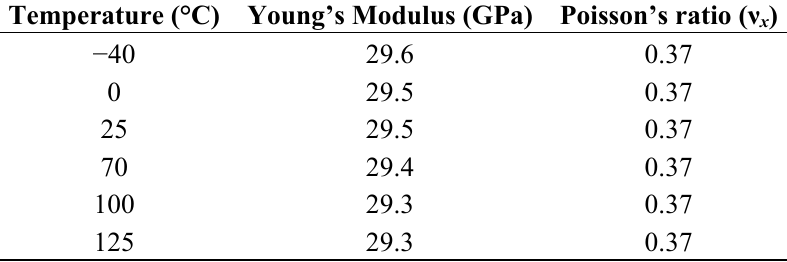
Table 1. Equivalent elastic mechanical properties of a microbump unit along the horizontal direction.